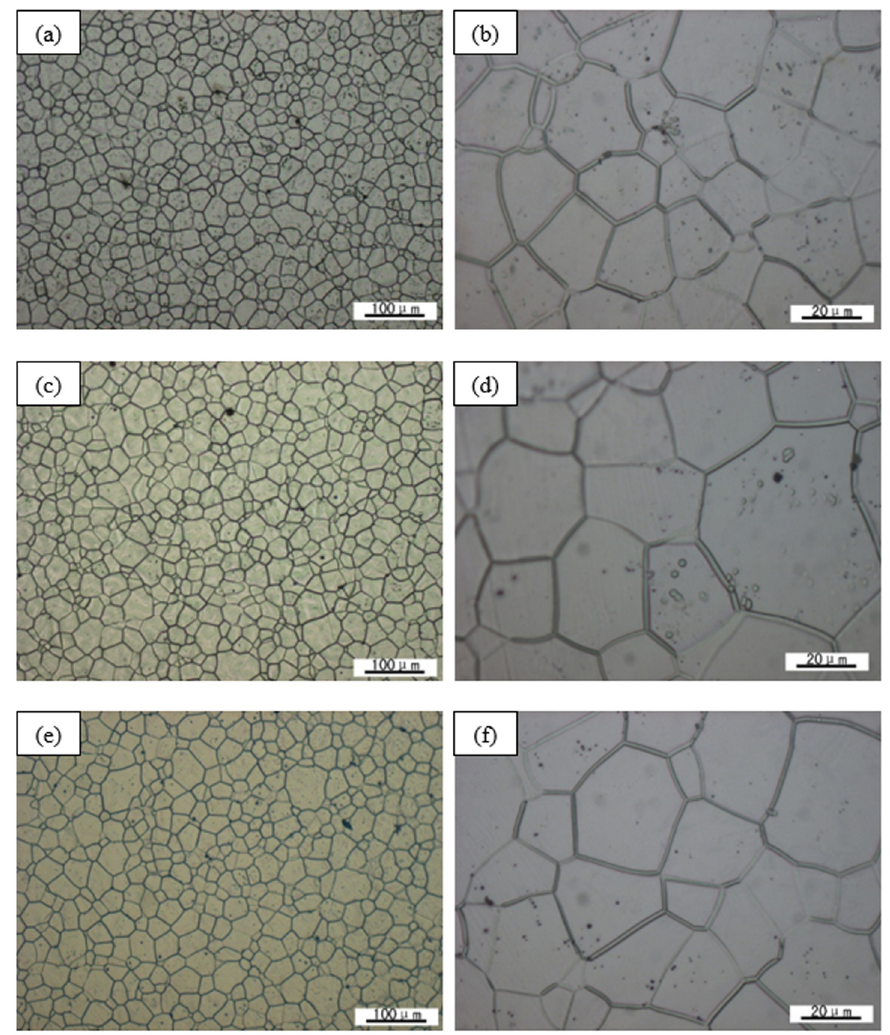
Figure 7. Optical microstructure of as-extruded GWK alloys: ( a , b ) GWK-a; ( c , d ) GWK-b; ( e , f ) GWK-c alloy.